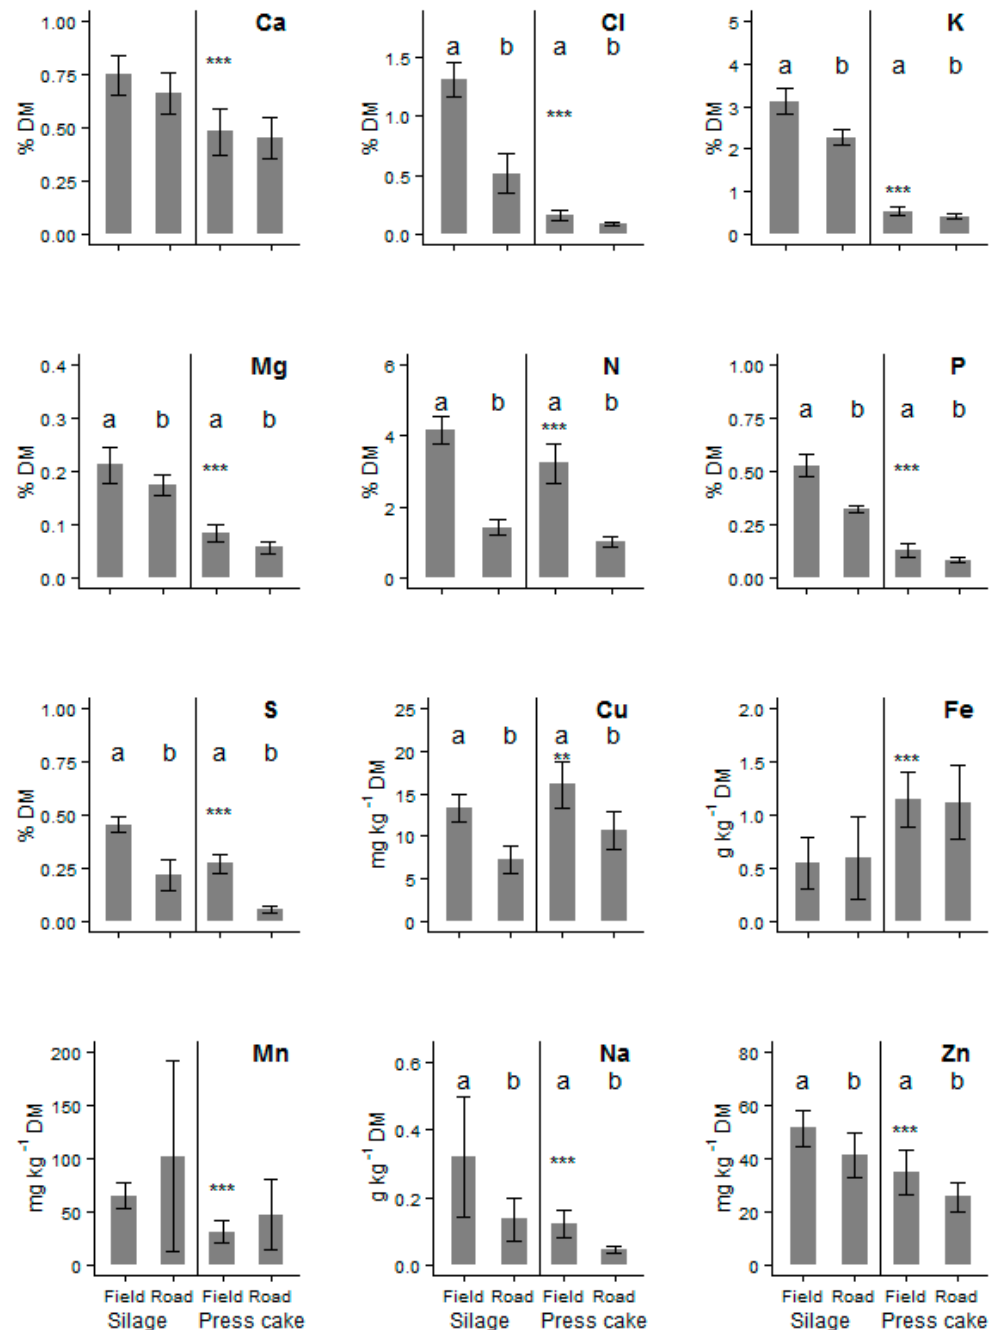
Figure 1. Element concentrations in grass from sports fields and urban roadside verges (2 cuts) for comparison. Data for urban roads are taken from [12], apart from Fe data, which are based on own measurements. The letters (a and b) indicate significant differences between silages and press cakes of different proveniences. Asterisks indicate significant differences between the silage and press cake of sports fields (**, p < 0.01; ***, p < 0.001).